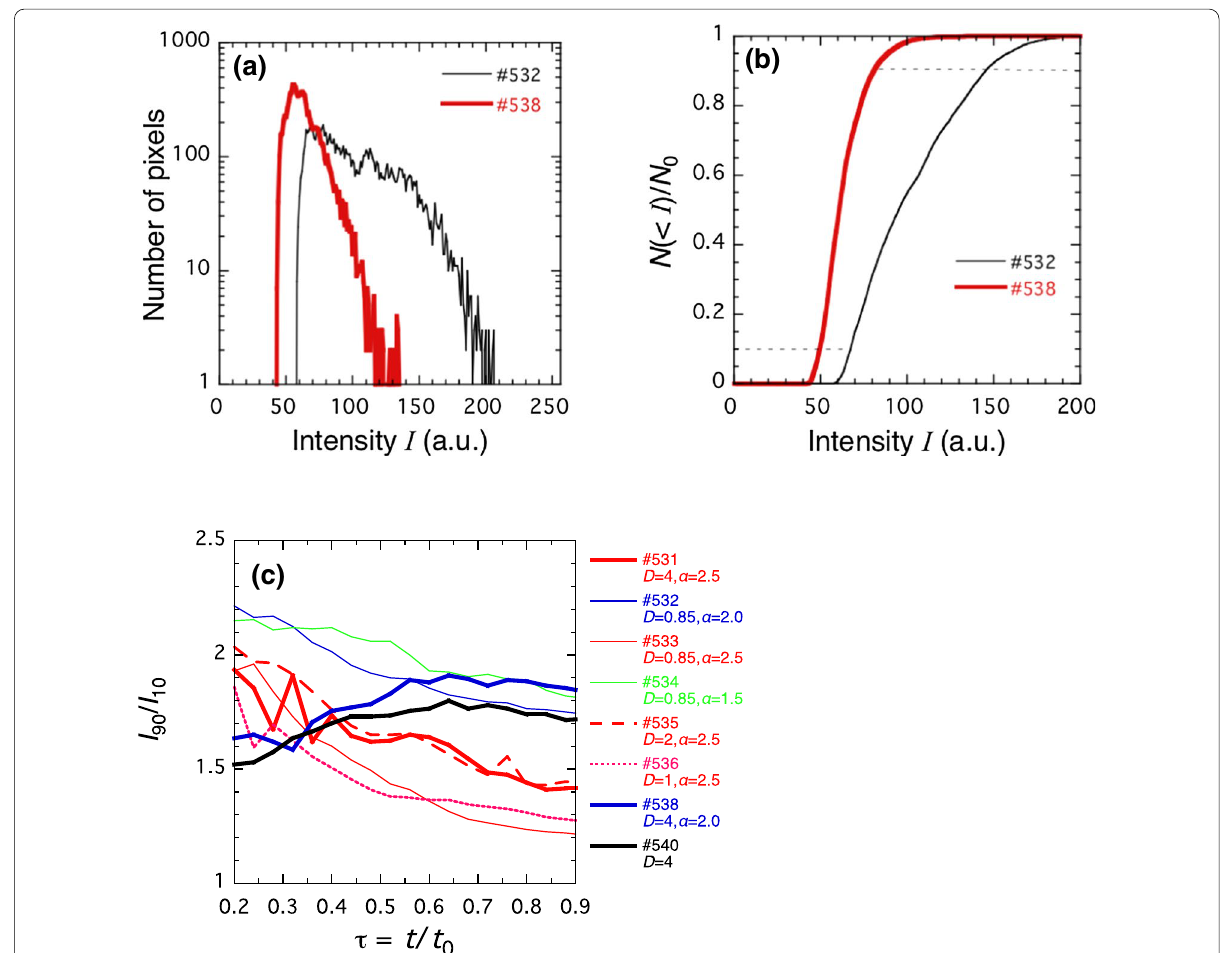
Fig. 4 a Intensity distributions at 28 ms after impact within the area with N 0 #538 ( D 4 mm, α 2.0) (bold red curve). b Cumulative number of pixels with an intensity lower than I , N (< I ), normalized by N 0 : #532 ( D = = α 2.0) (thin black curve) and #538 ( D 4 mm, α 2.0) (bold red curve). The horizontal broken lines indicate N (< I )/ N 0 of 0.9 and 0.1. c The ratio = = = of the intensities at N (< I )/ N 0 of 0.9 and 0.1, I 90 / I 10 . The horizontal axis is the normalized time τ , i.e., the time after the impact t divided by the characteristic crater formation time